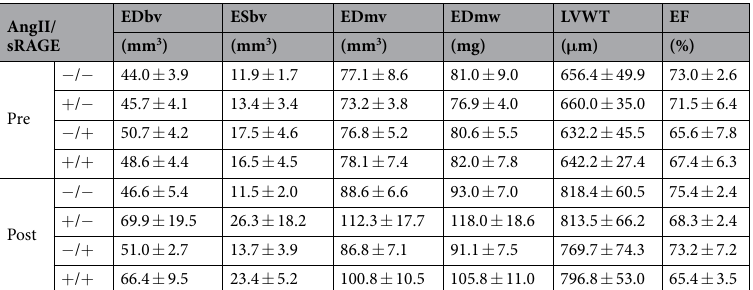
Table 1. The factors were selected as indicators of cardiac function in this